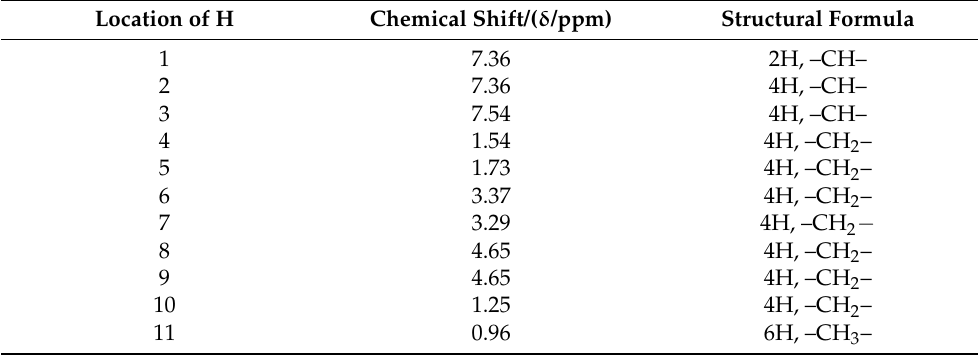
Table 3. Analytical table of the 1 H-NMR spectrum for bis[(3-ethyl-3-methoxyoxetane)